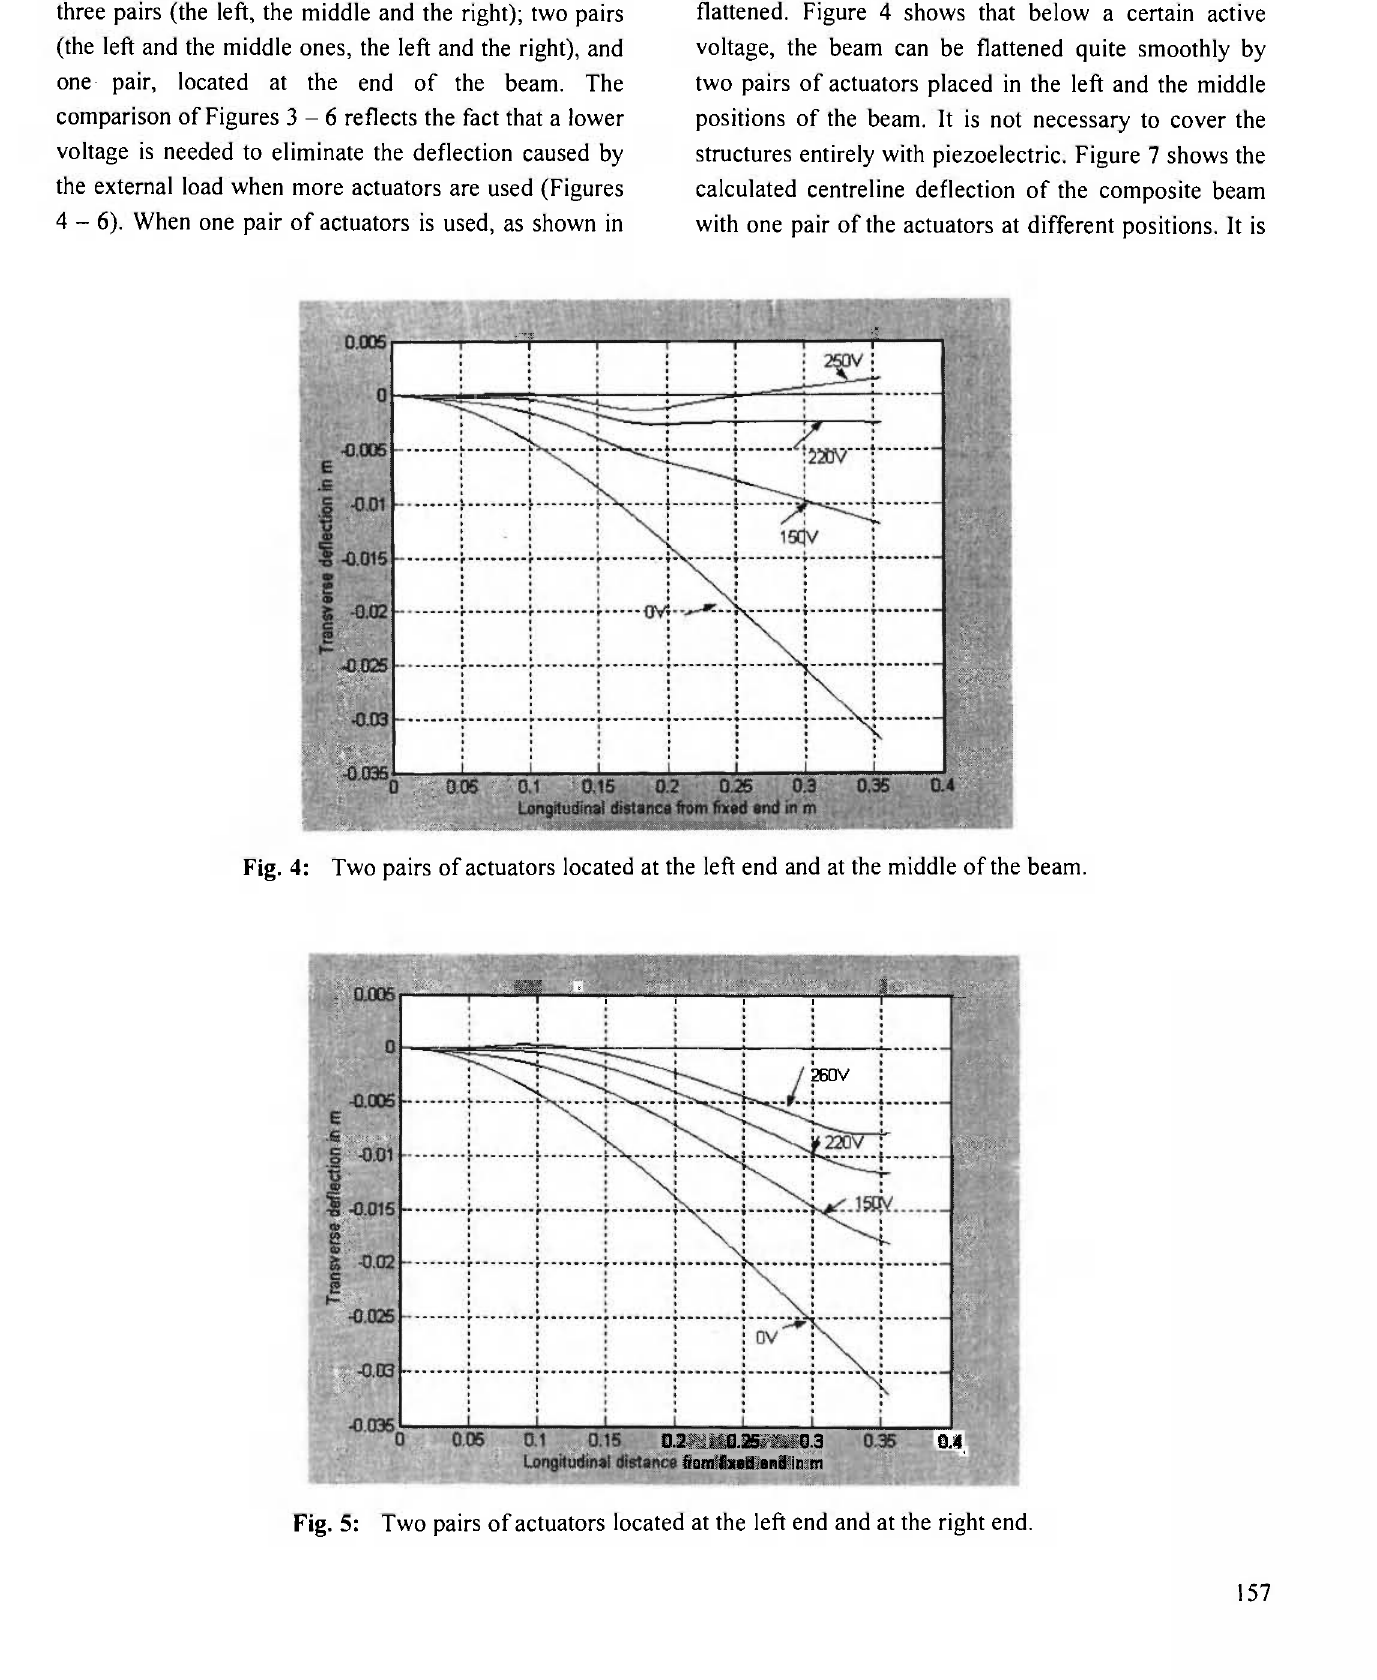
Fig. 5: Two pairs of actuators located at the left end and at the right